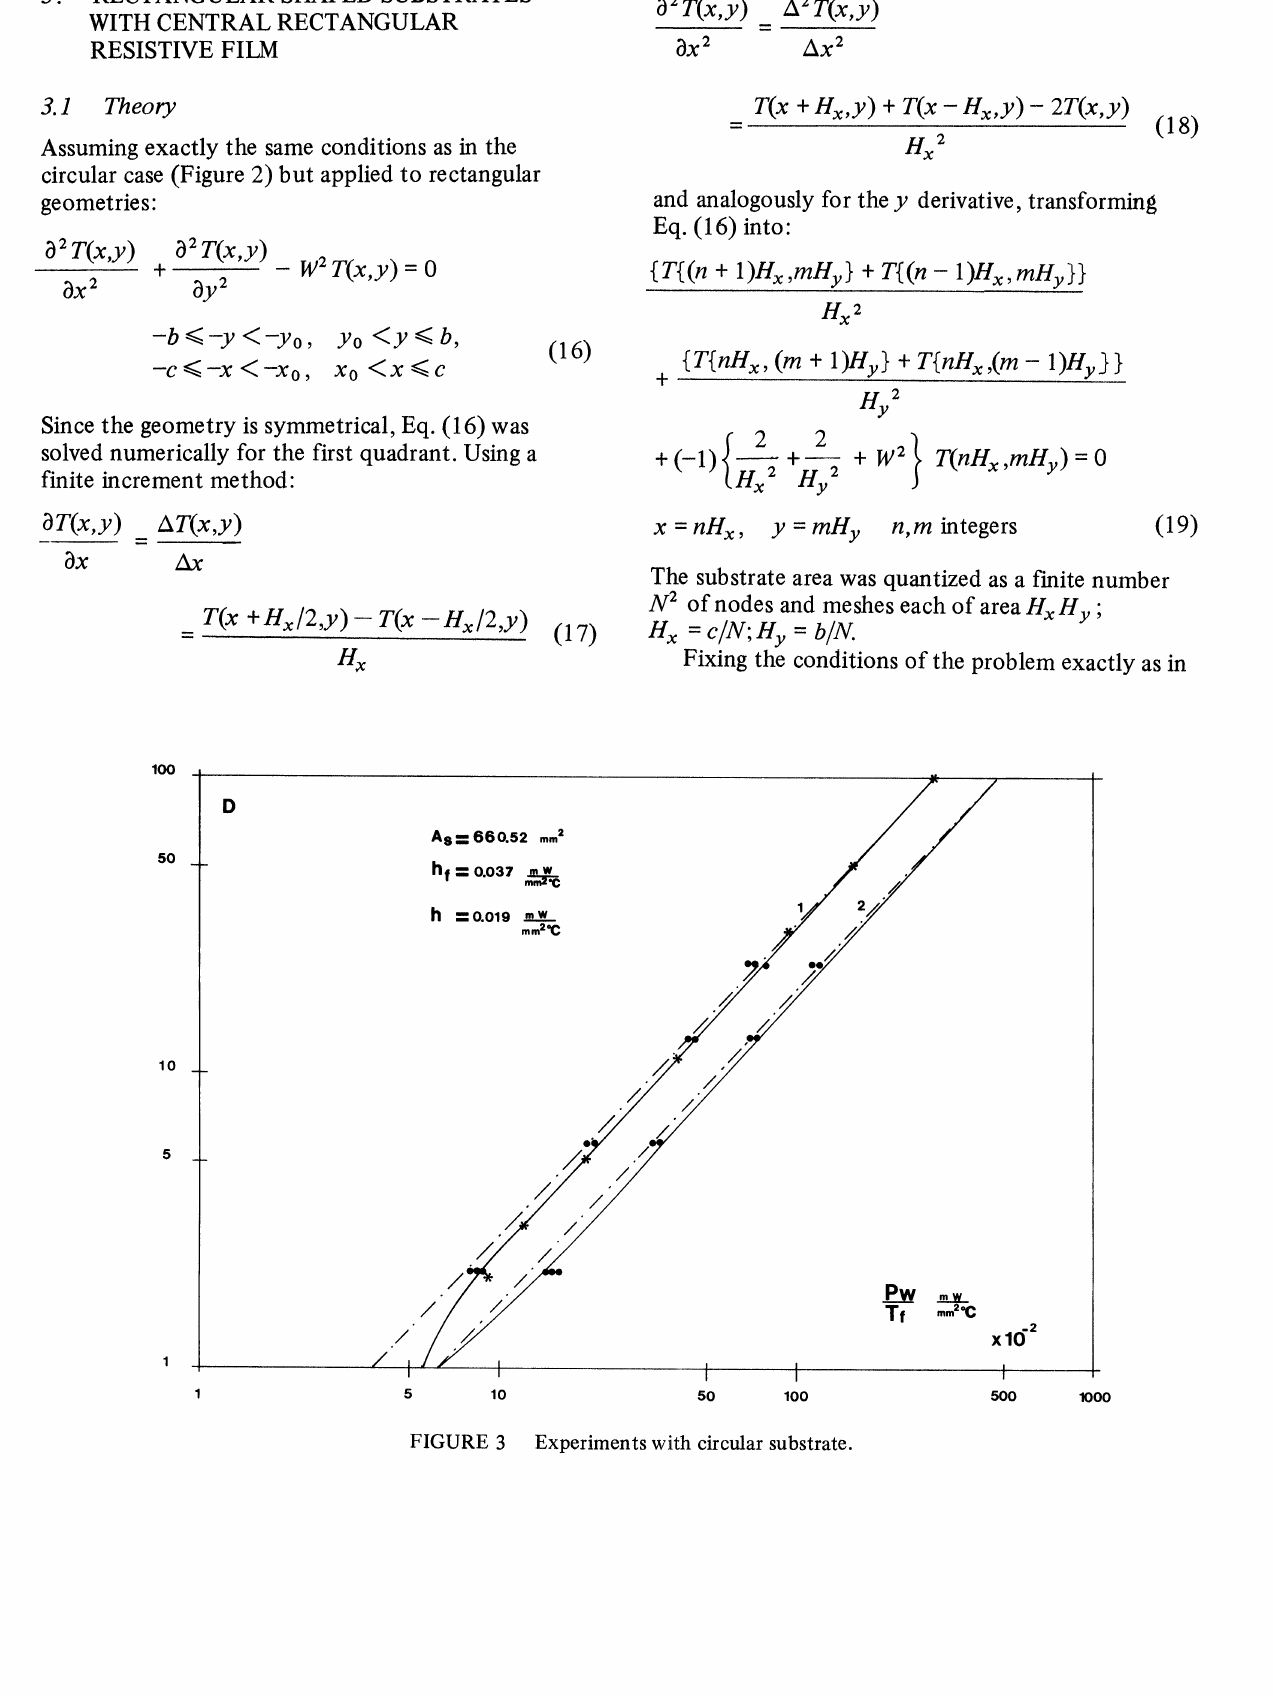
FIGURE 3 Experiments with circular